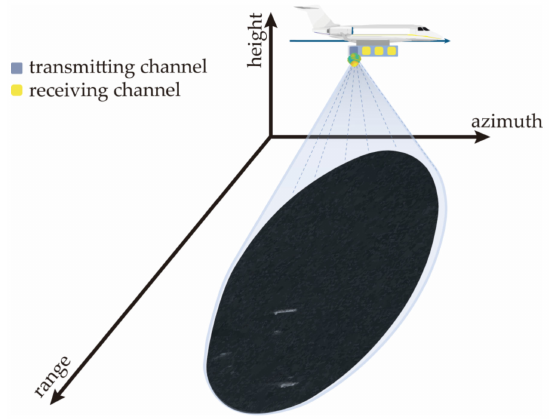
Figure 1. Azimuth multichannel SAR imaging